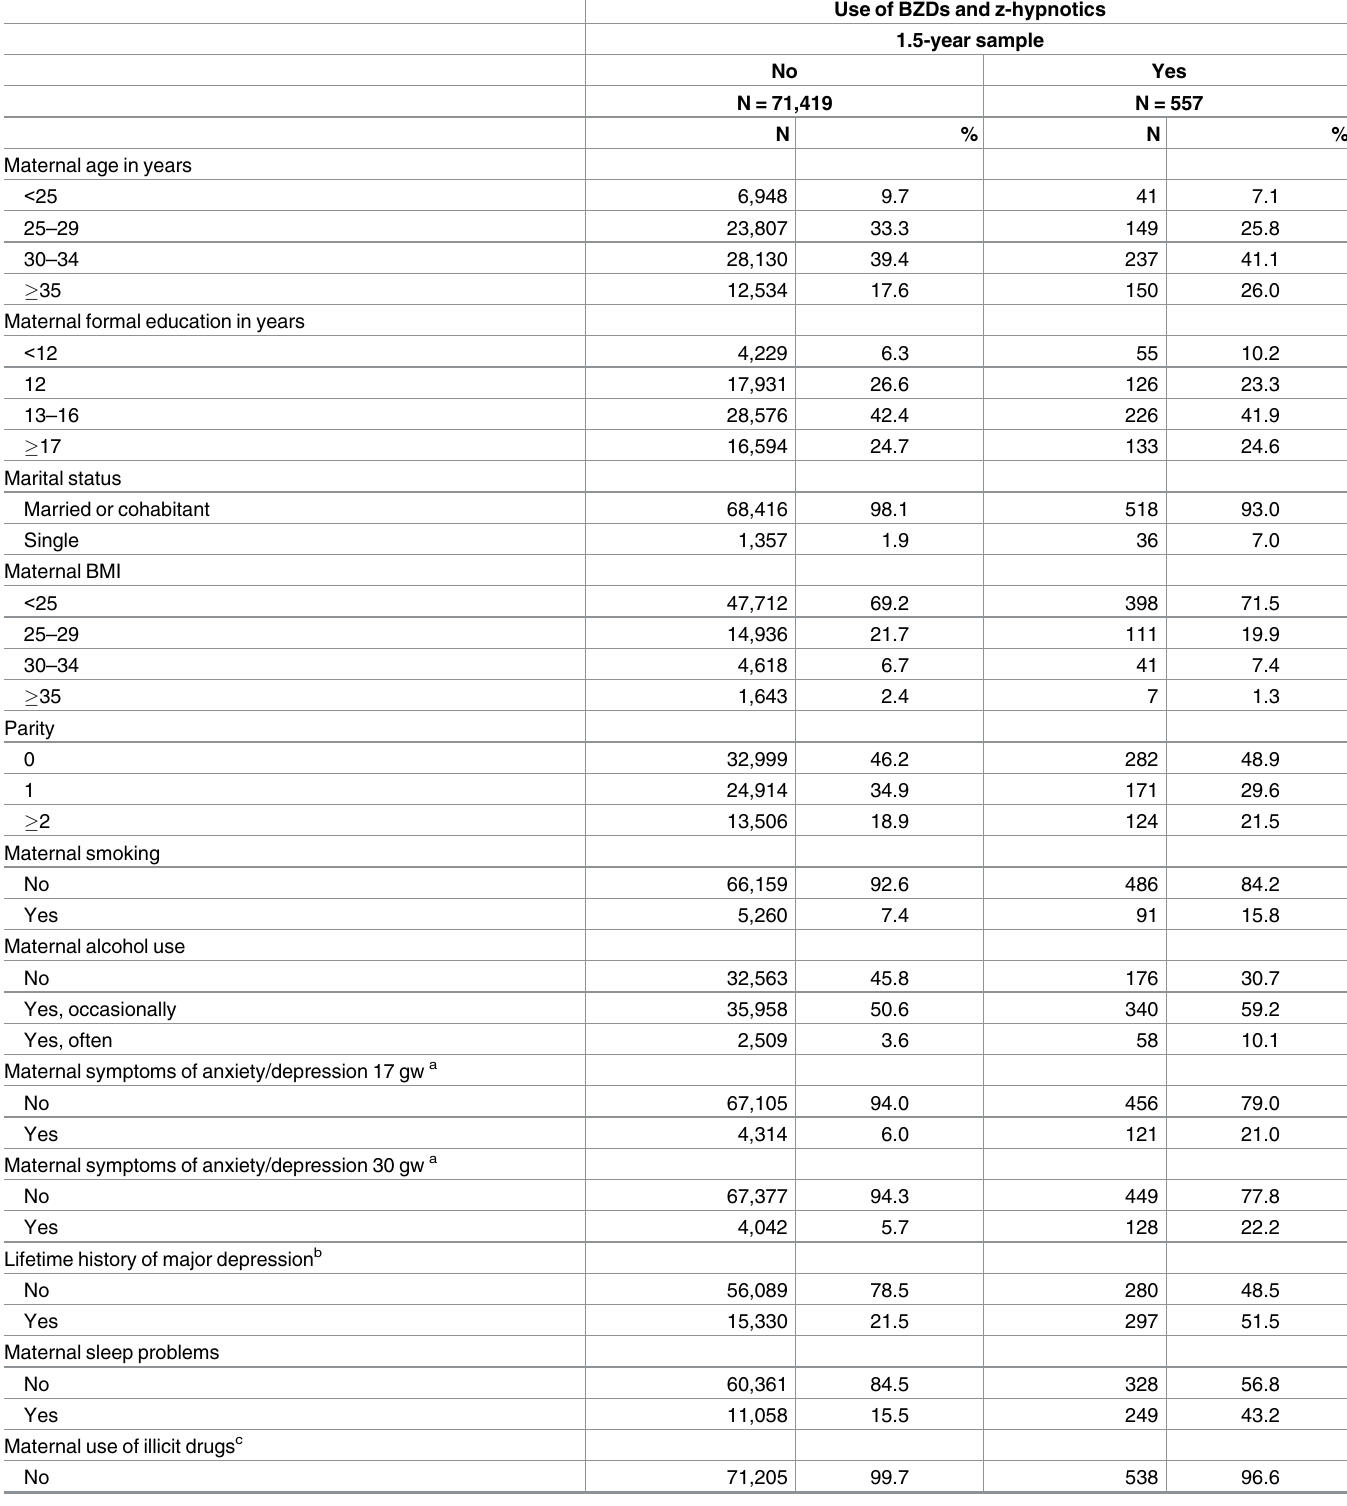
Table 2. Maternal characteristics by use of BZDs and z-hypnotics during pregnancy in the 1.5 year MoBa